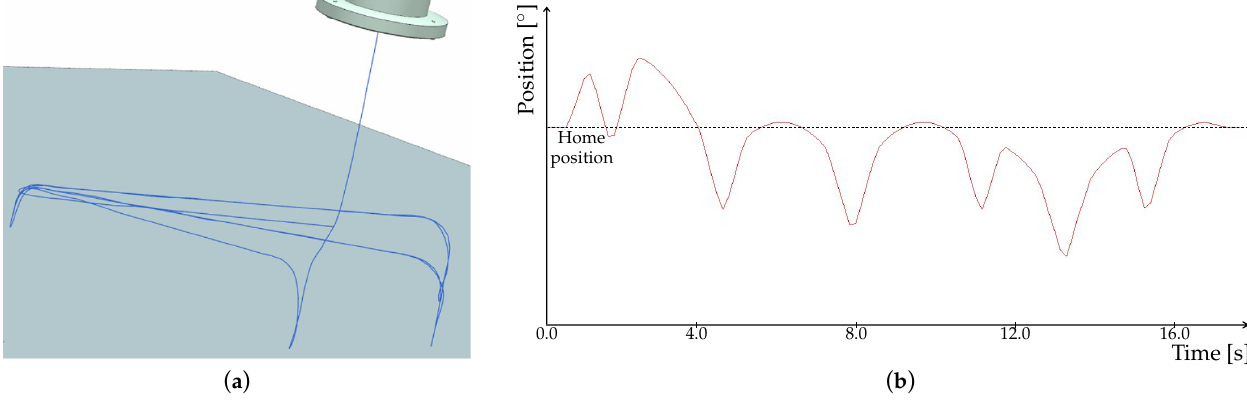
Figure 14. Results from simulation in NX MCD using OPC UA NET server. ( a ) Trace of the tool. ( b ) Time profile of the signal adapter for axis position control.